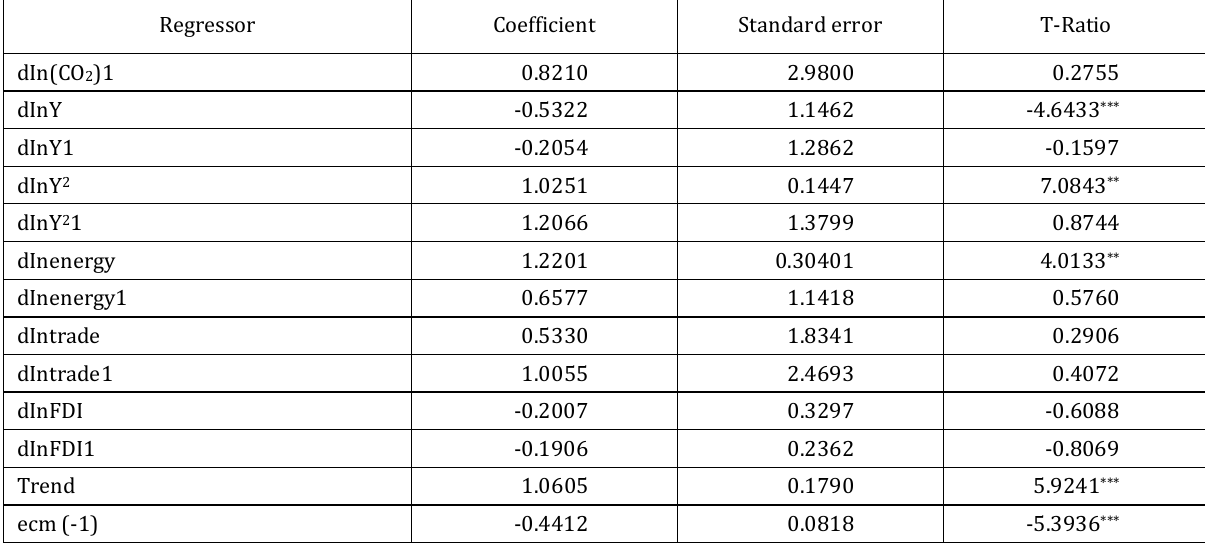
Table 4. Results of the Error Correction Model (source: author’s